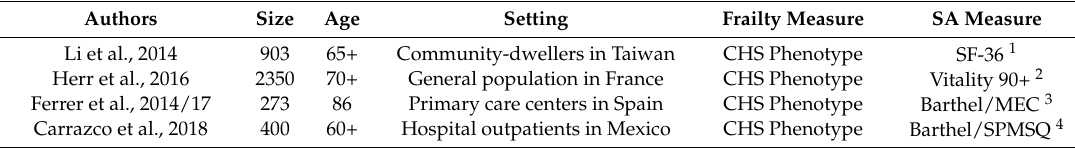
Table 1. Original research articles that employed explicit criteria for frailty and successful